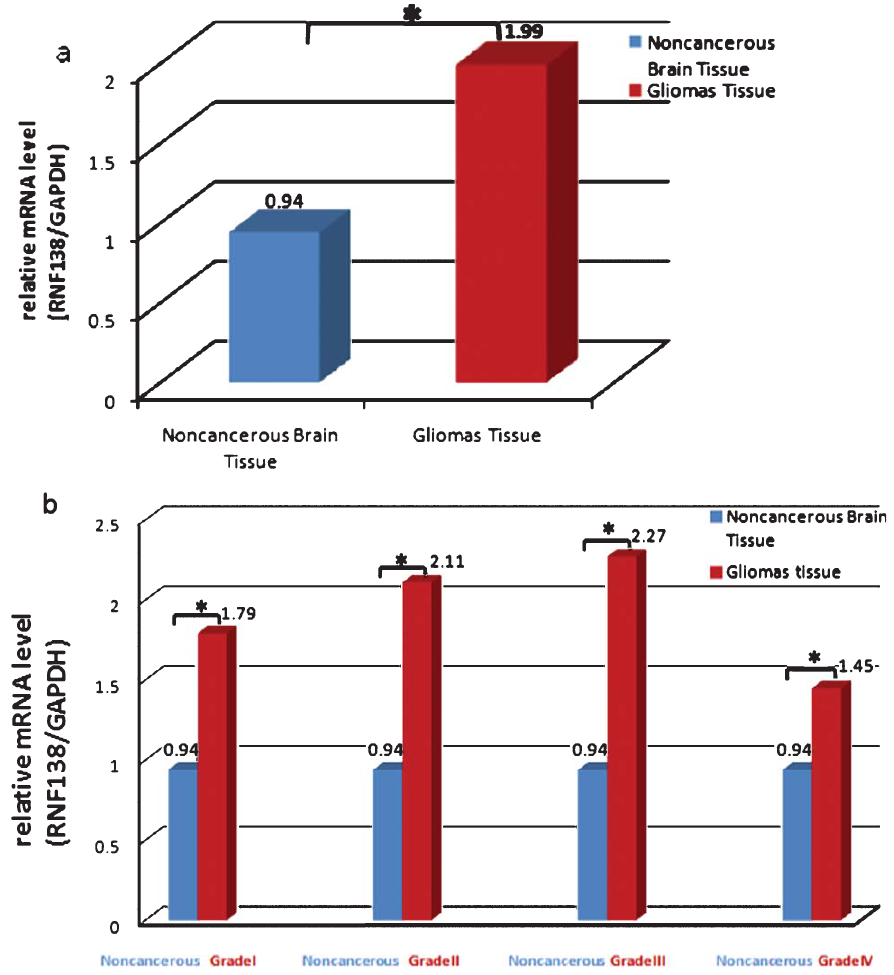
Fig. 2. The relative expression levels of RNF138 mRNA in the gliomas samples and the noncancerous brain tissue detected by real-time quantitative PCR. (a) the elevated expression level of RNF138 in all the 35 gliomas samples (including the Grade I to Grage IV) versus the noncancerous brain tissue. (0.94 ± 0.16 vs. 1.99 ± 0.36, respectively; p =0.01). (b) the elevated expression level of each grade gliomas versus the noncancerous brain tissue. * P